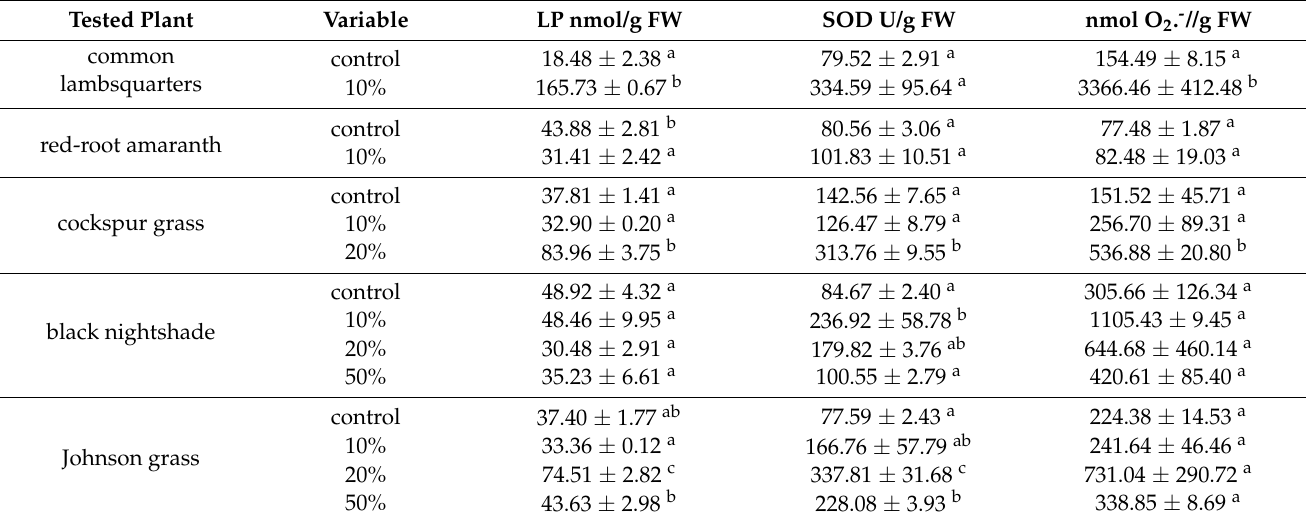
Table 6. Biochemical analysis of the treated weed species 14 days after the